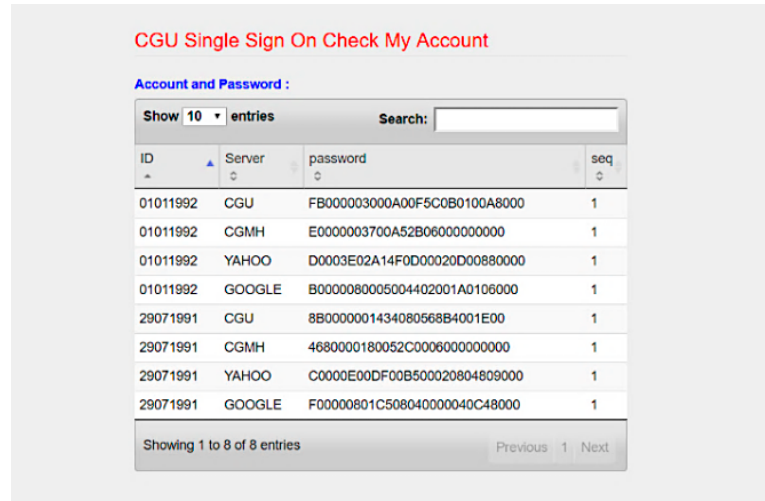
Figure 17. Interface of account checking.